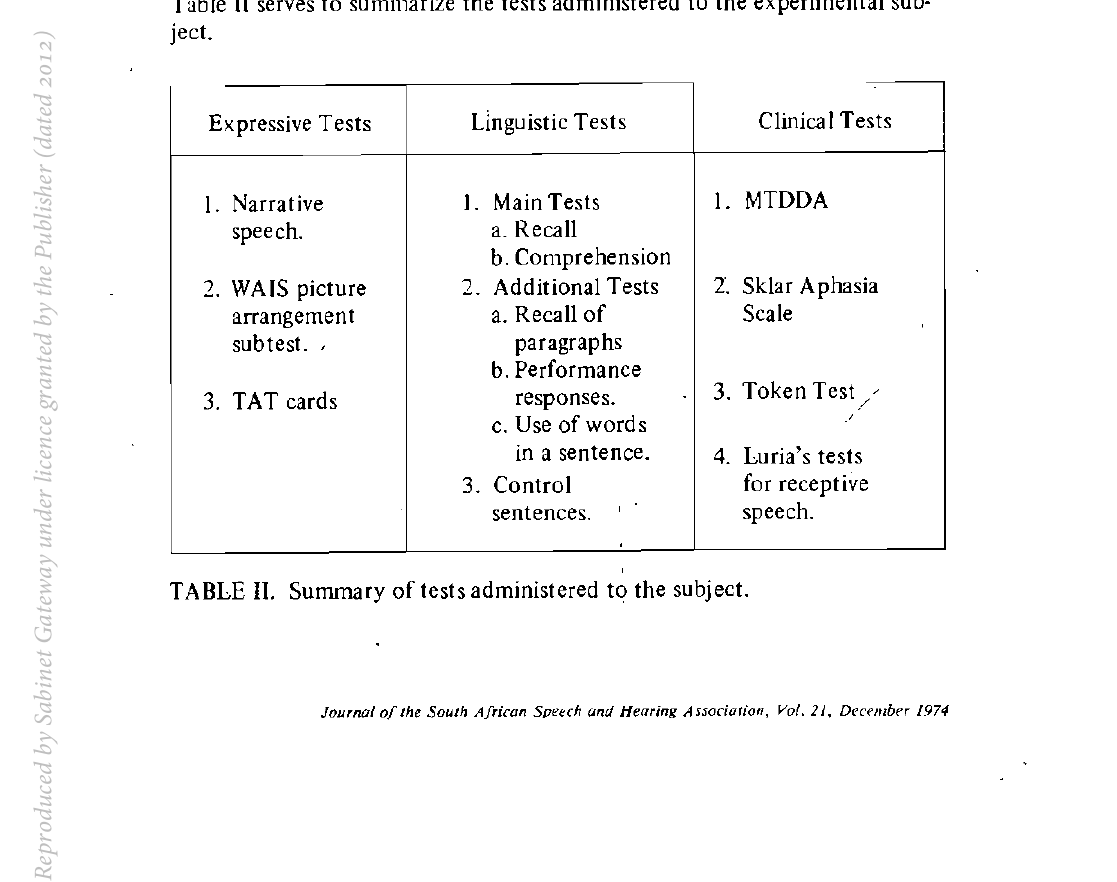
TABLE II. Summary of tests administered to the